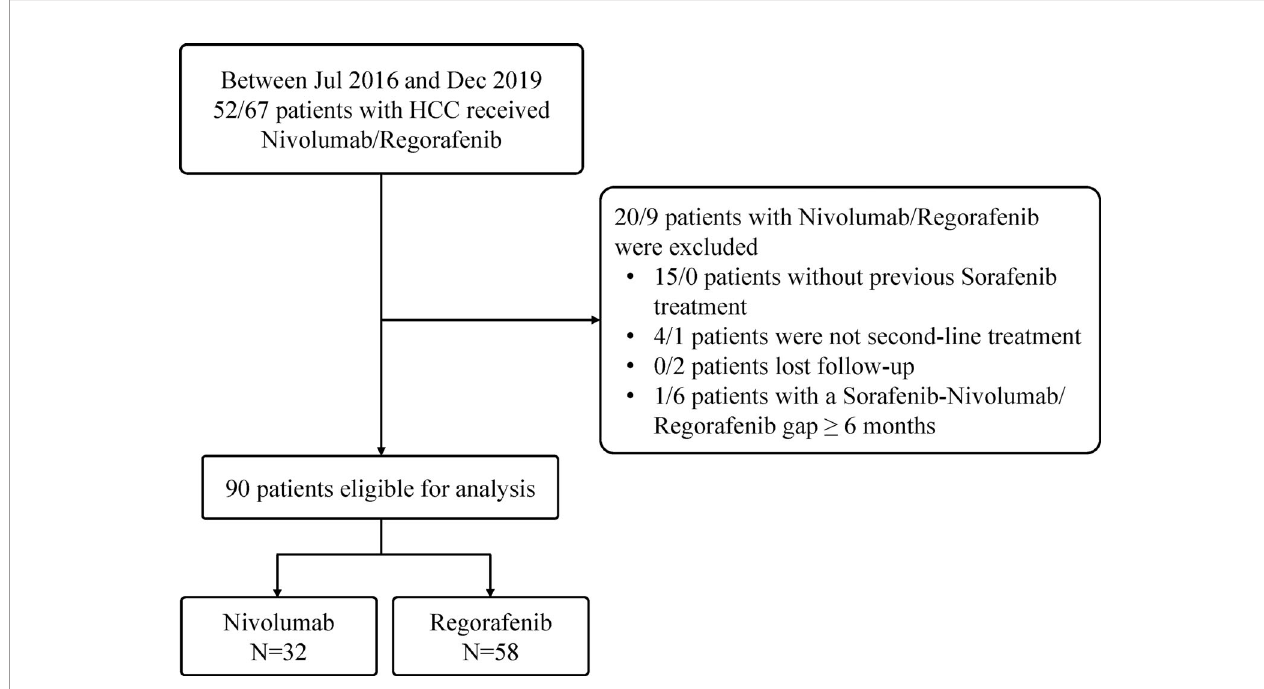
FIGURE 1 | Flow chart of study